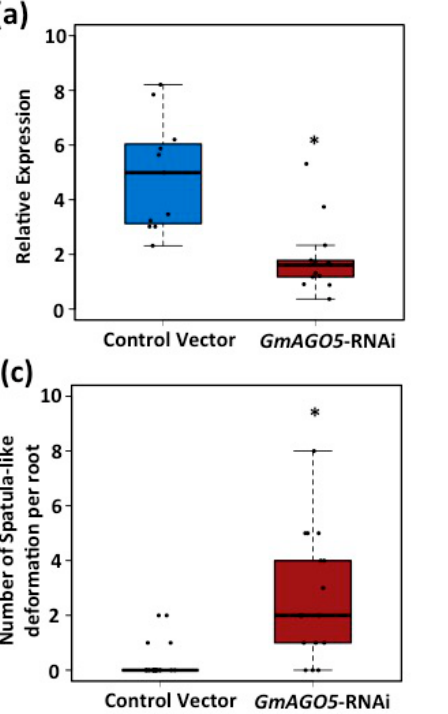
Figure 6. GmAGO5 -silenced soybean roots develop rhizobia-induced spatula-like root hair deformation. ( a ) GmAGO5 expression levels in transgenic roots expressing a control vector or the GmAGO5 -RNAi construct. Data shown was obtained from ten independent biological replicates, each one containing roots from four different composite plants; ( b ) Rhizobia-induced root hair deformation in transgenic soybean roots expressing a control vector or the GmAGO5 -RNAi construct; ( c ) Number of rhizobia-induced spatula-like deformed root hairs observed in control transgenic roots and GmAGO5 -silenced roots. One-way ANOVA followed by a Tukey HSD test was performed. Asterisk indicates a significant difference ( p -value < 0.01).